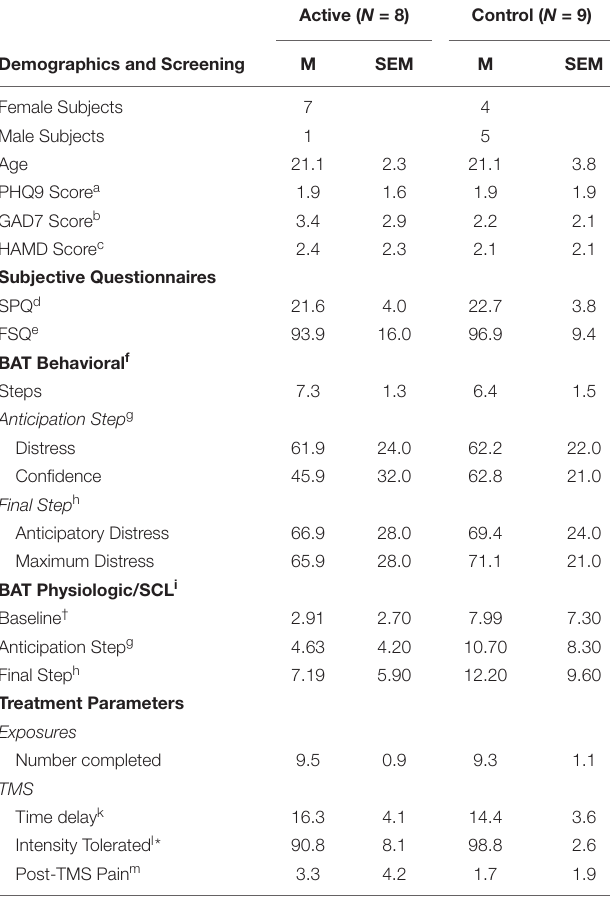
TABLE 1 | Baseline demographic and screening data, as well as pre-treatment baseline measurement of outcome variables and experimental parameters. Active ( N = 8) Control ( N =